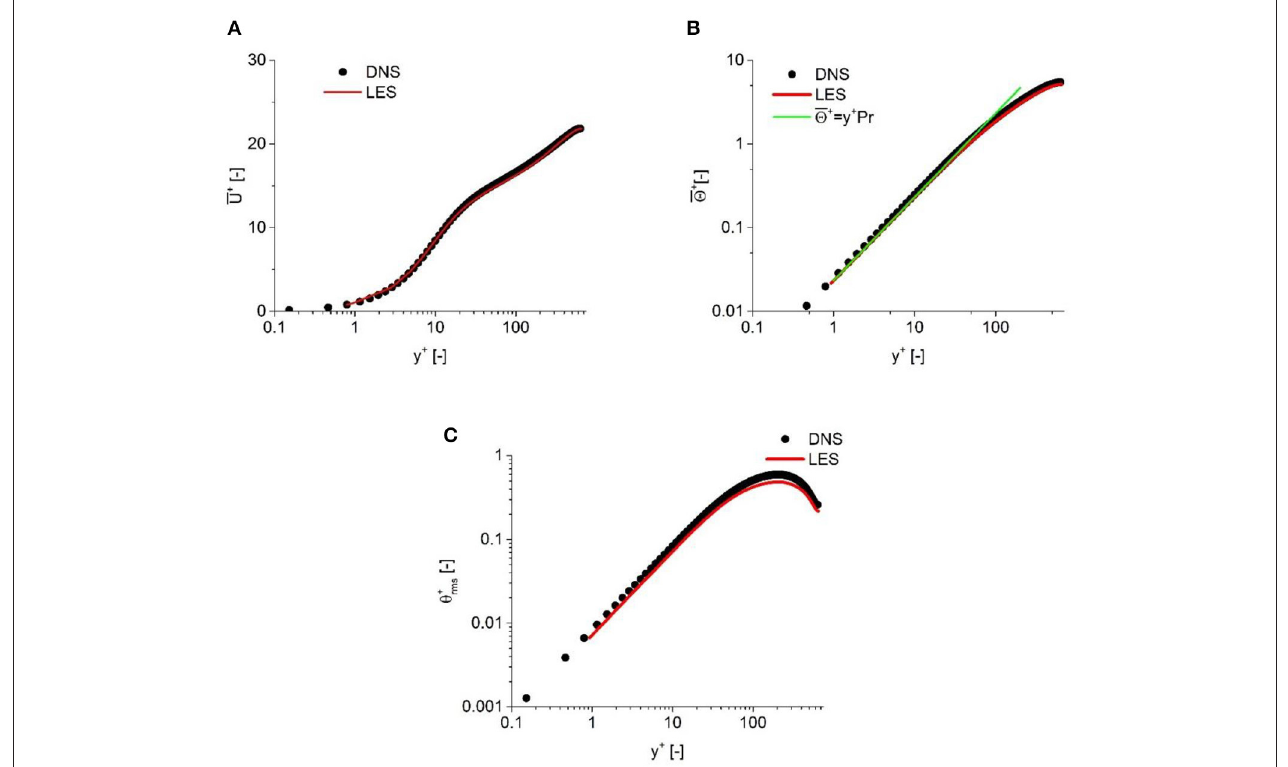
FIGURE 2 | Comparison against the results of Abe et al. (2004). (A) Mean velocity, (B) Mean temperature, and (C) Root mean square of temperature variance.